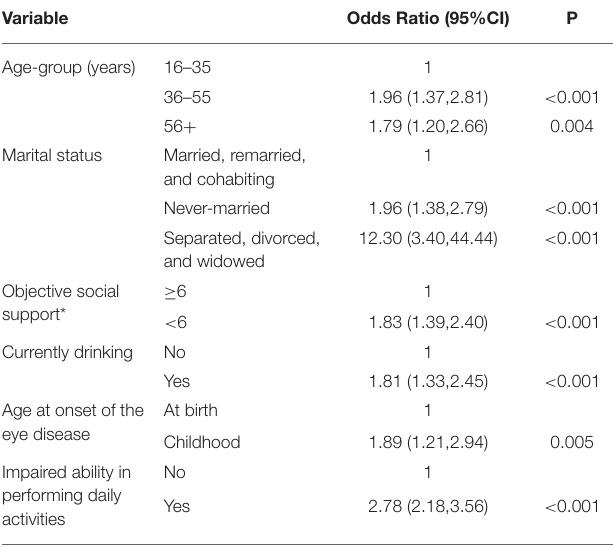
TABLE 2 | Factors significantly associated with major depressive disorder in persons living with vision disability.